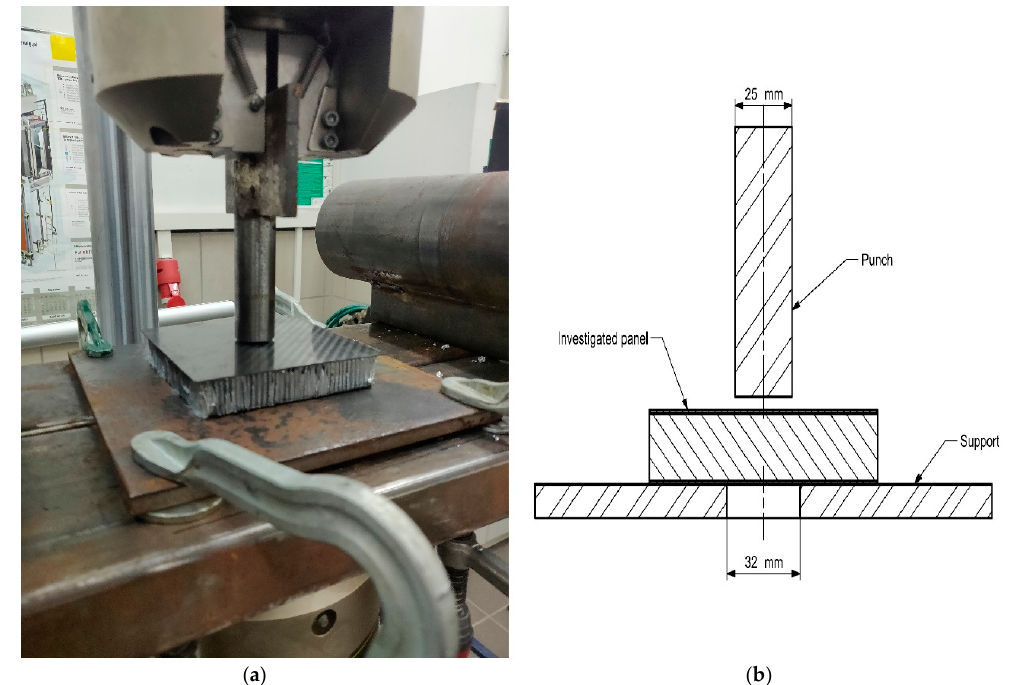
Figure 2. Perimeter shear test setup . ( a ) assembly on the test machine ( b ) cross-sectional view of the setup.